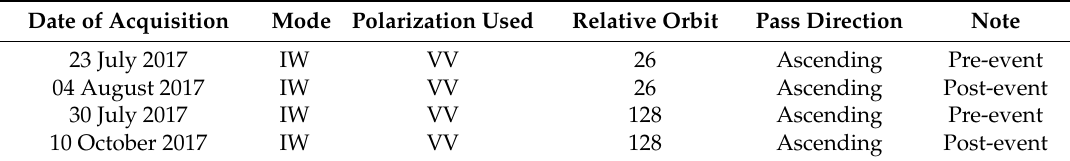
Table 1. Sentinel-1A SAR images used for flash flood detection.